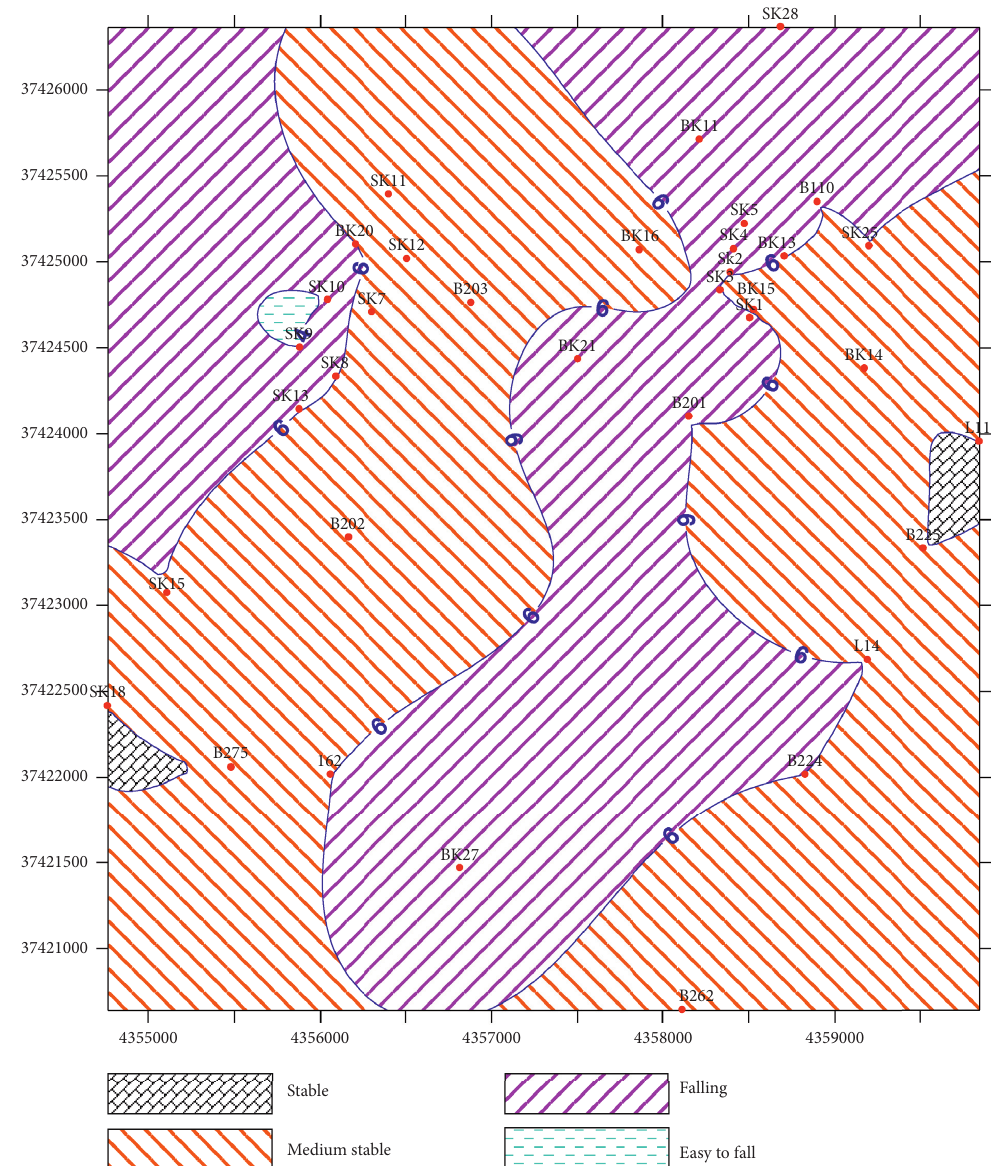
Figure 5: The stability equal line figure of number 2–2 coal seam roadway roof of